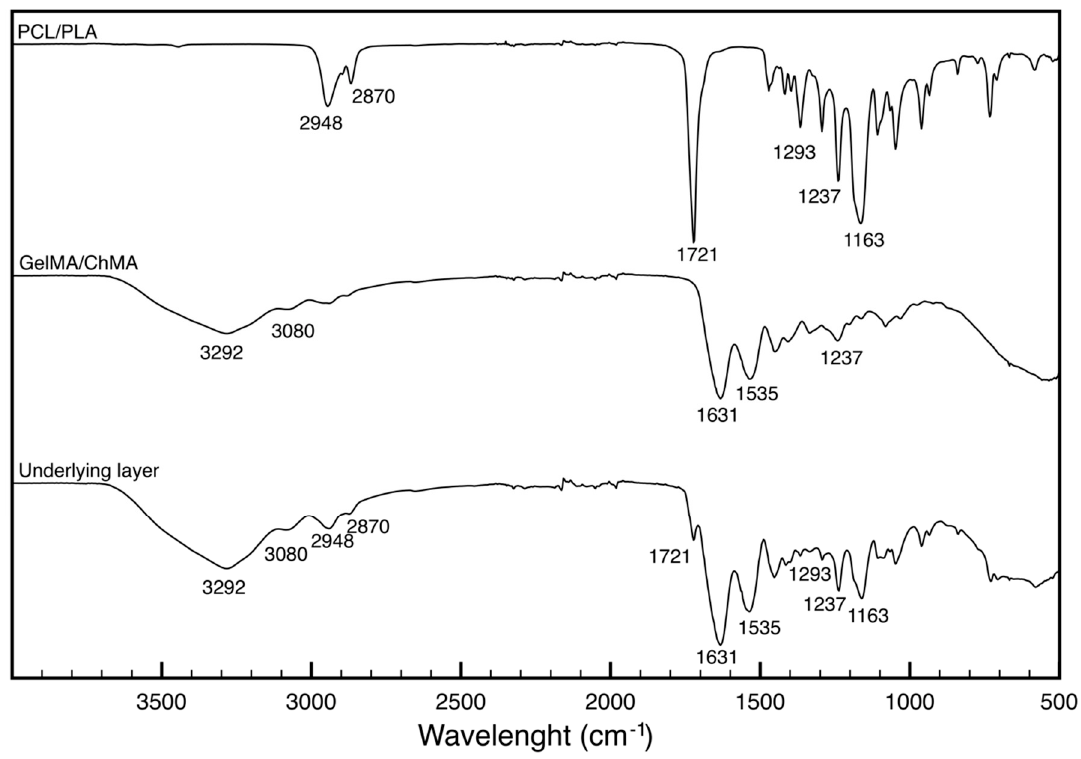
Figure 3. FTIR-ATR spectra of the individual PCL/PLA and GelMA/ChMA membranes and of the underlying layer of the membrane.